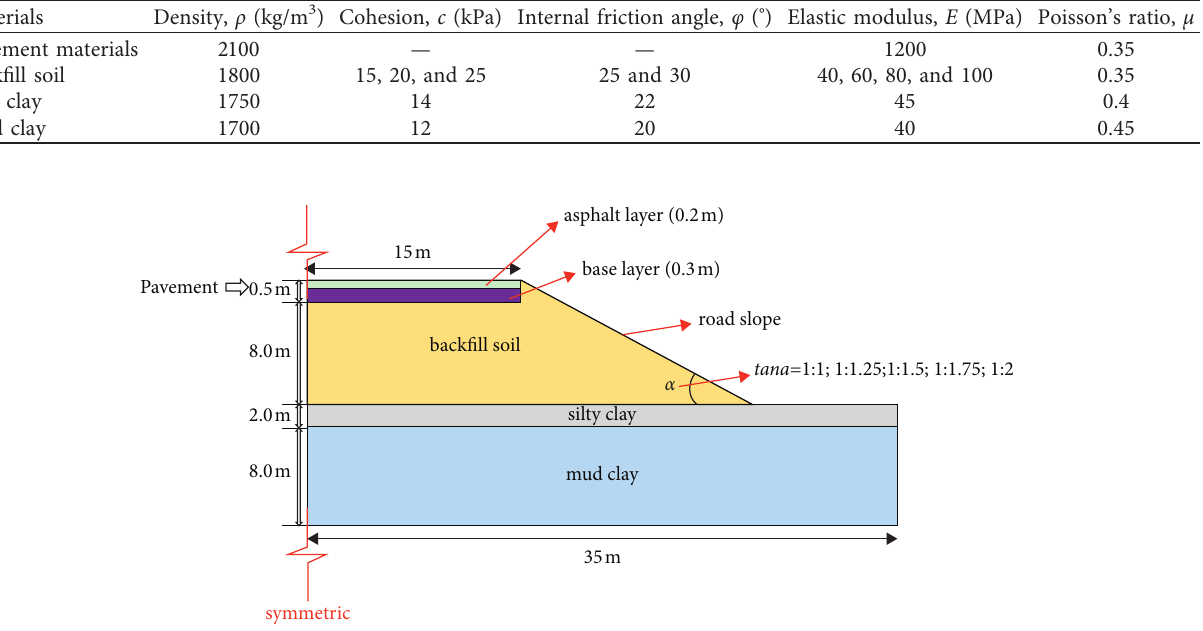
Table 1: Material properties.